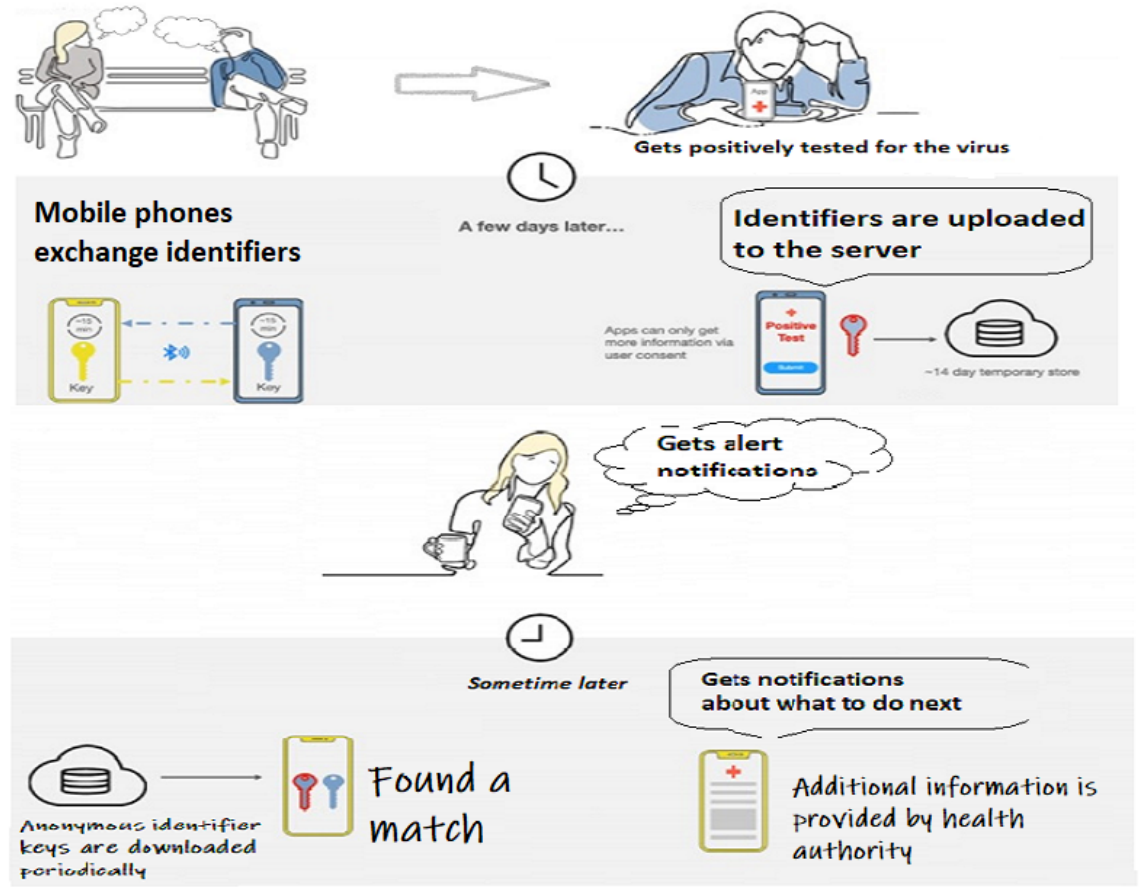
Figure 2. The Exposure Notification